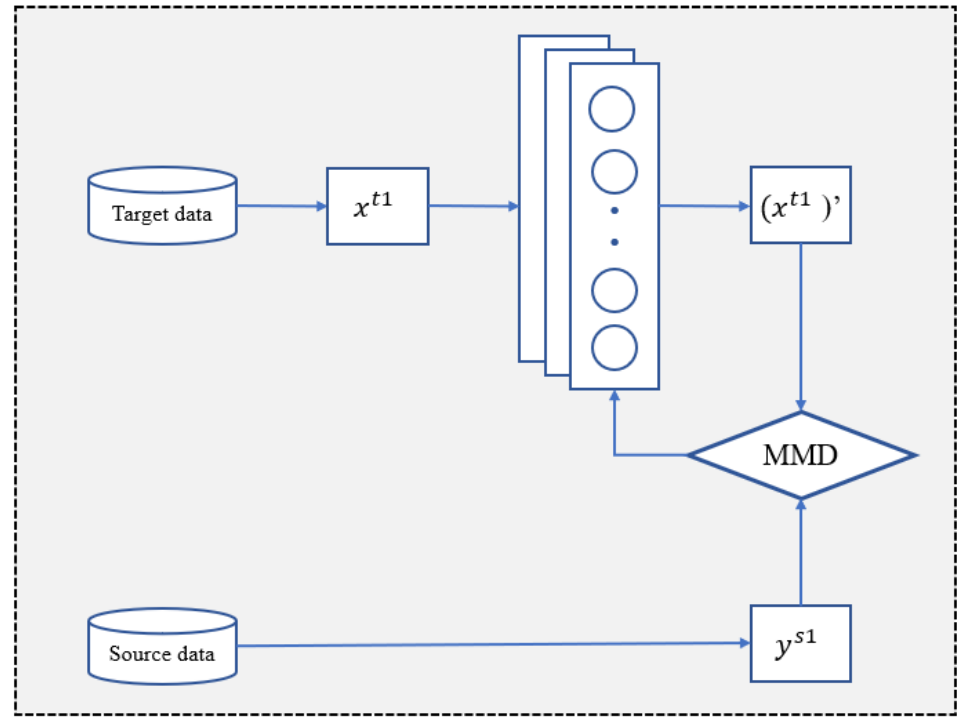
Figure 2. Data adaptation mapping network.